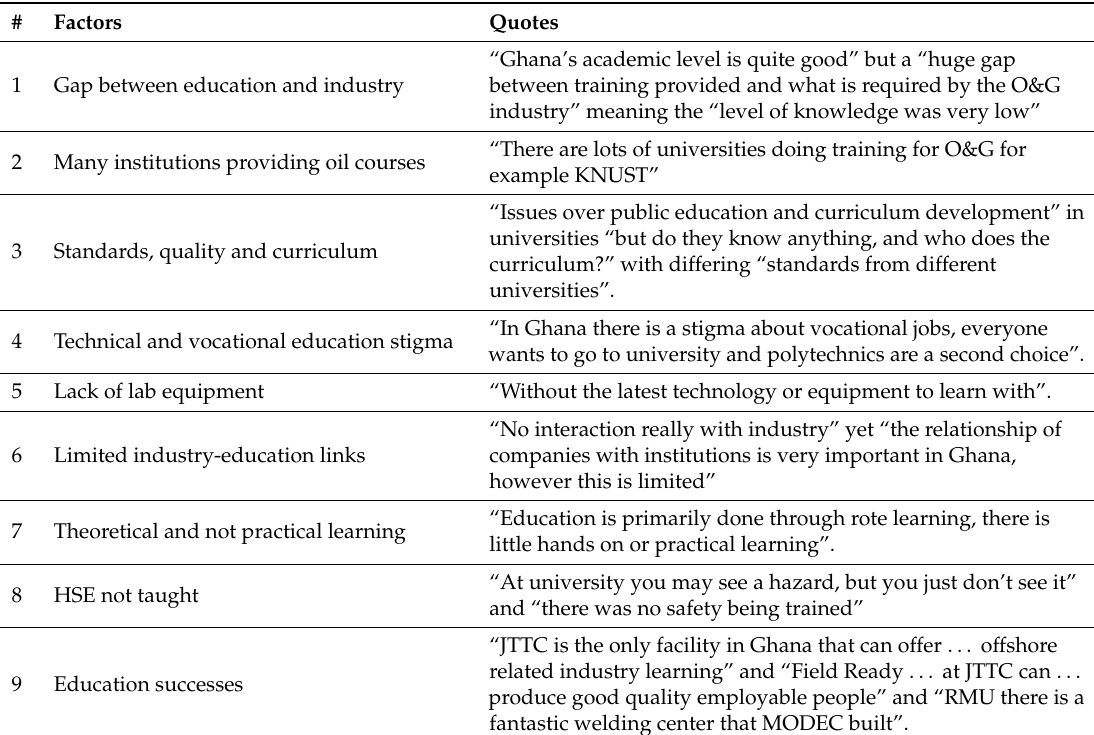
Table 5. ‘Higher and vocational education & training’